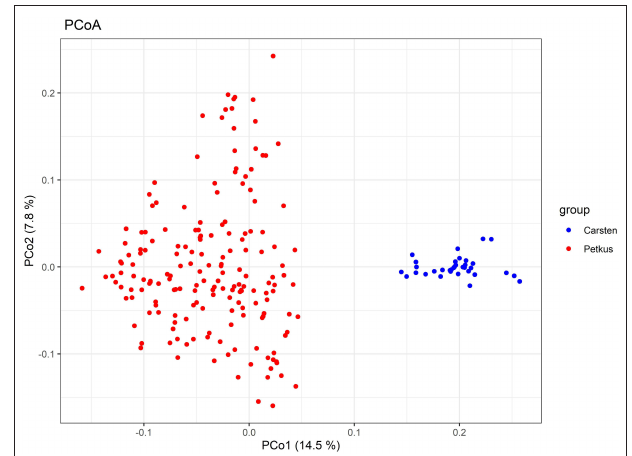
FIGURE 4 | Principal coordinates analysis (PCoA) of 214 elite seed and pollen parent lines. Scatter plot of the first two principal coordinates based on genotyping data of 2,965 SNP markers. The horizontal and vertical coordinates represent PCo1 and PCo2. Each dot represents a line. Samples are colored according to the heterotic gene pools ‘Petkus’ (seed parent pool) and ‘Carsten’ (pollen parent pool).